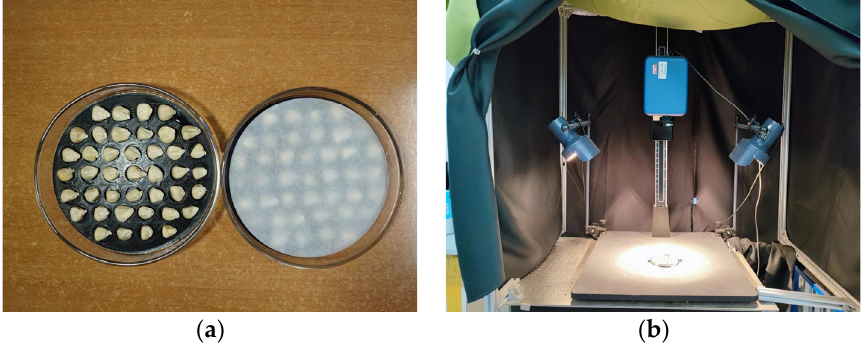
Figure 2. The experimental processes. ( a ) Bud stimulating experiment; ( b ) spectral acquisition experiment. Table 1. Germination test to determine seed viability in all groups.